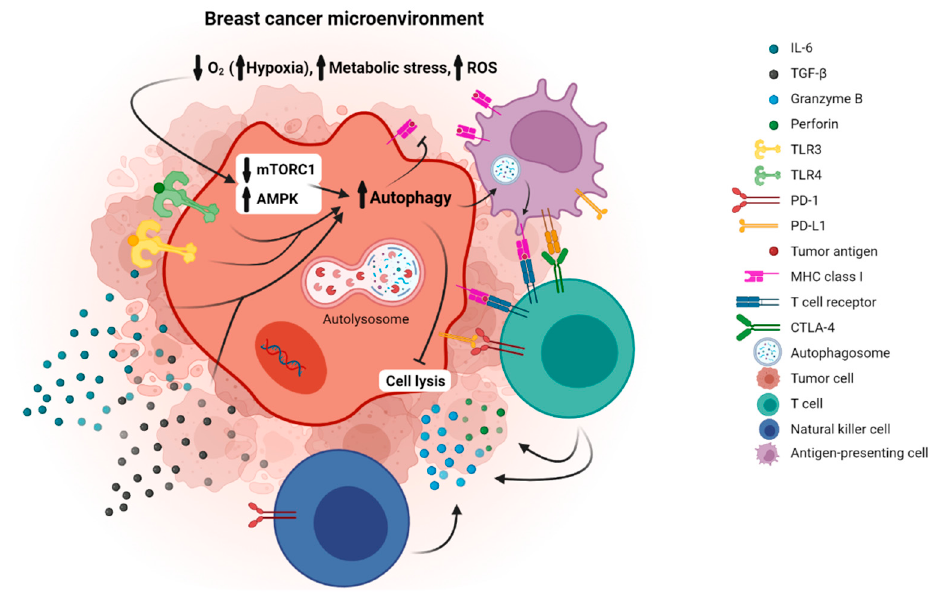
Figure 1. This figure summarizes pathways and molecules that contribute to breast cancer cell survival through autophagy induction. The increased metabolic stress, hypoxia, and ROS (reactive oxygen species) characterizing the cancer cell microenvironment leads to the inhibition of AKT and mammalian target of rapamycin (mTOR), resulting in autophagy induction. The latter is associated with autophagy-mediated antigen degradation and inhibition of DCs activity, impairing T cell-mediated killing and promoting tumor growth [103–105].